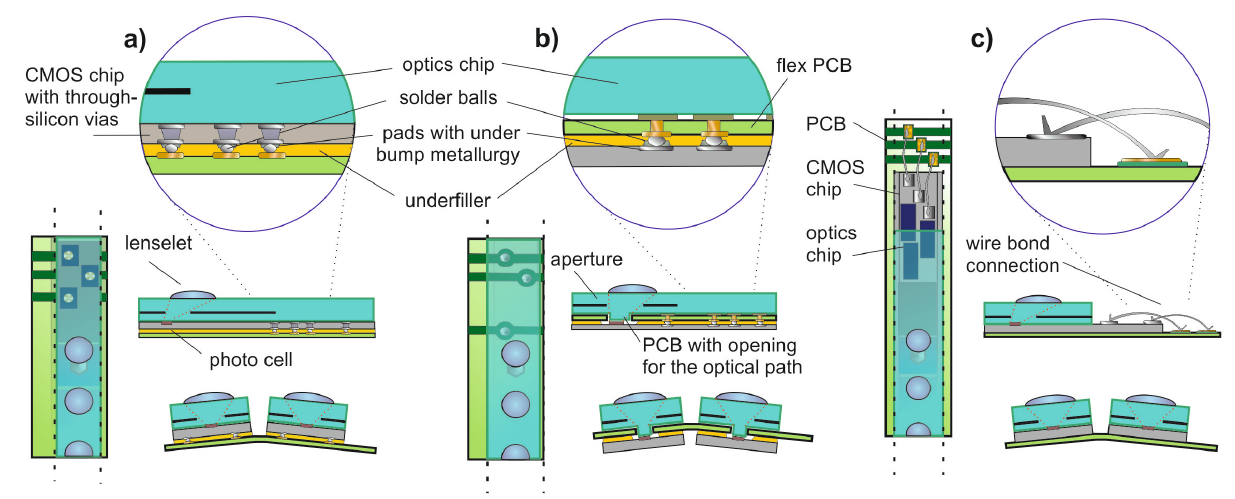
Figure 8. Evaluated assembly concepts: ( a ) Flip chip bonding with backside PCB. This solution requires through silicon vias (TSVs) on the CMOS chips, but would allow for wafer-scale processing. ( b ) Flip chip bonding with the PCB sandwiched between the optics and CMOS chips. This solution implies more complex assembly and PCB layout. ( c ) Wire bonding of the column pads to the flexible PCB. This solution is particularly suitable for small series